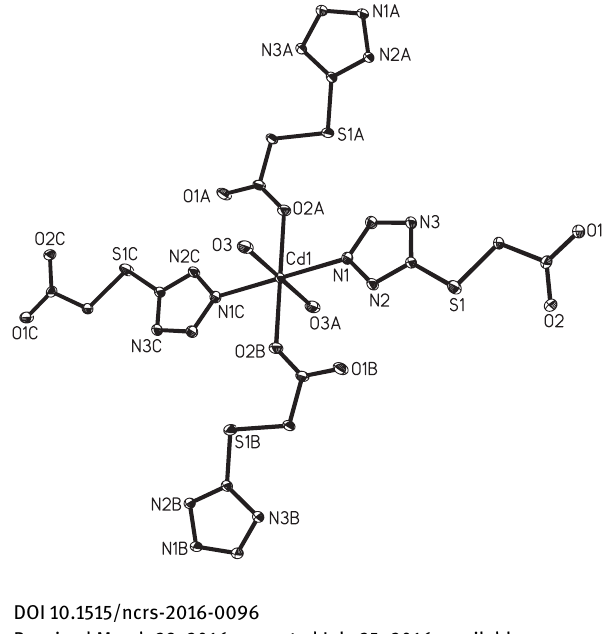
Table 1: Data collection and handling.